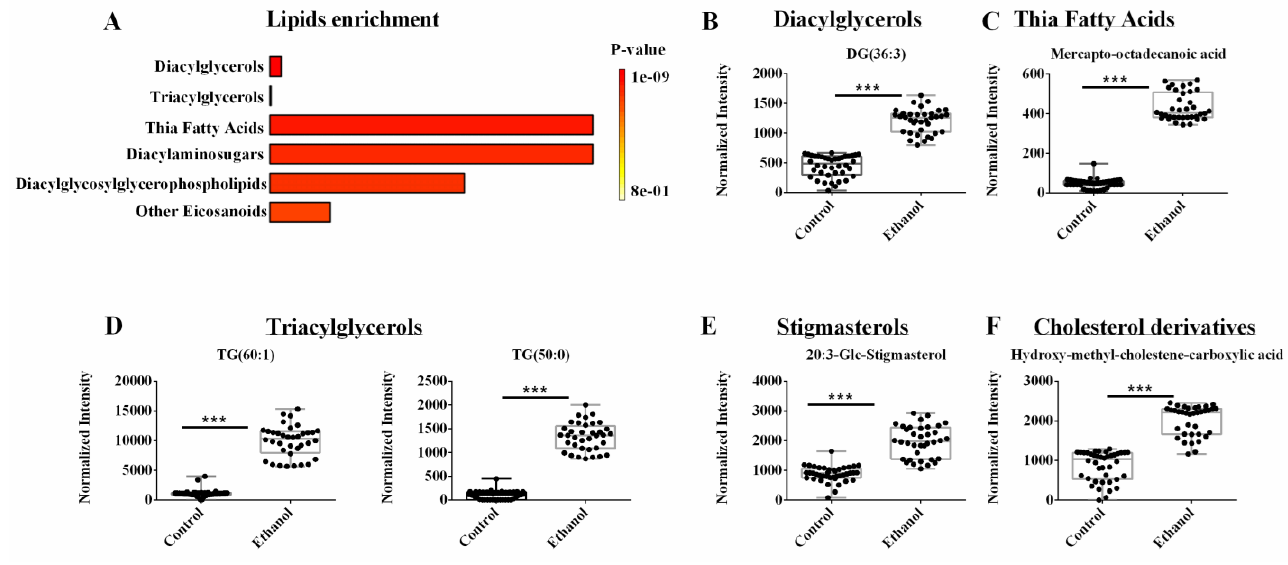
Figure 5. ( A ) An enrichment analysis of the 39 lipids from the LC-MS lipidomics data set with a statistically significant change in hepatocyte cells following ethanol exposure. ( B – F ) Representative box plots of lipids from the top enriched pathways in ( A ) that highlight the top lipid changes in the lipidomics data sets. All the metabolites demonstrated a fold change > 2.0 and an FDR p- value < 0.001 using the Benjamini-Hochberg method. Compound class and names are listed above the box plots. *** p- value < 0.001.